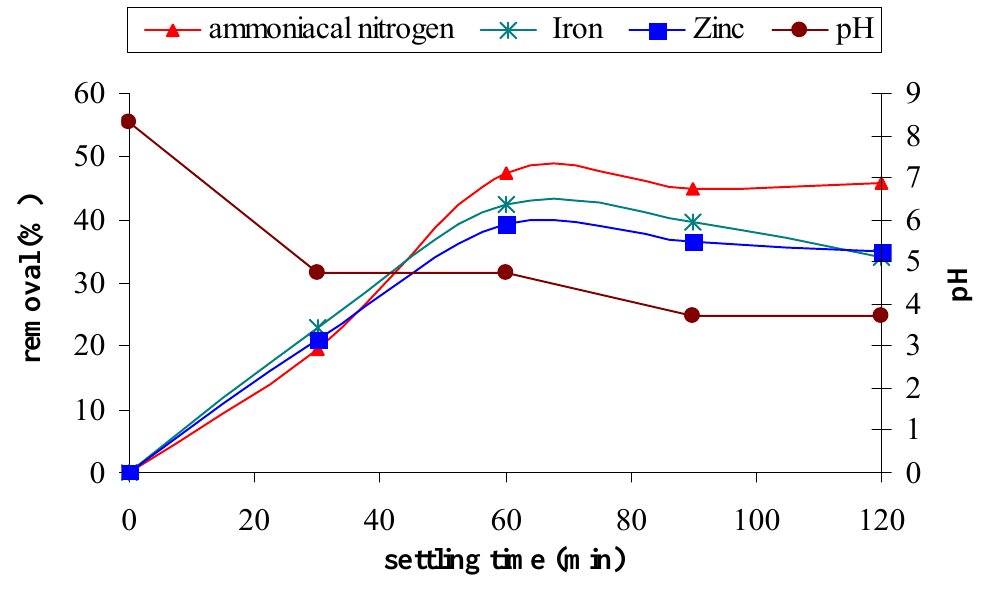
Figure 2. Influence of settling time on ammoniacal nitrogen, iron and zinc removal efficiency (dosage = 40 g; shaking speed = 350 rpm; shaking time = 90